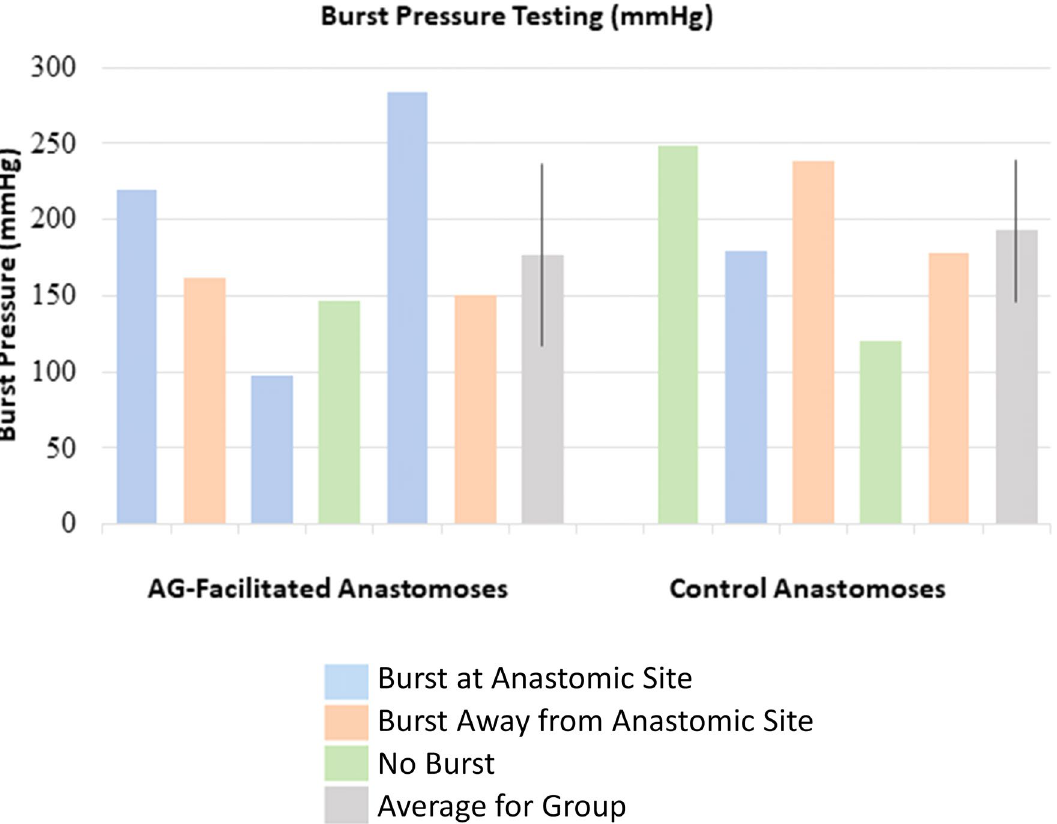
Figure 10. Burst pressures achieved by each anastomosis. Blue bars represent samples in which bursting occurred at the anastomotic site. Orange bars represent samples in which bursting occurred at the bowel adjacent to the anastomotic site but the anastomotic site remained intact. Green bars represent the maximum pressure achieved within the bowel lumen with no burst achieved. Grey bars signify the average for each group, and the overlying black lines represent standard